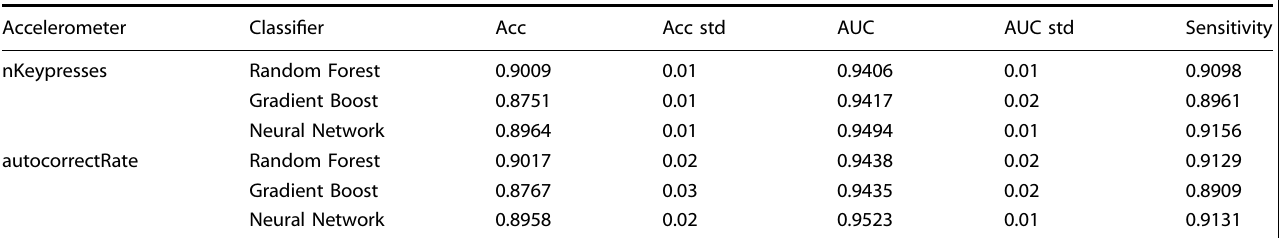
Table 6. Sensor Fusion of arc_sum feature with typing features.